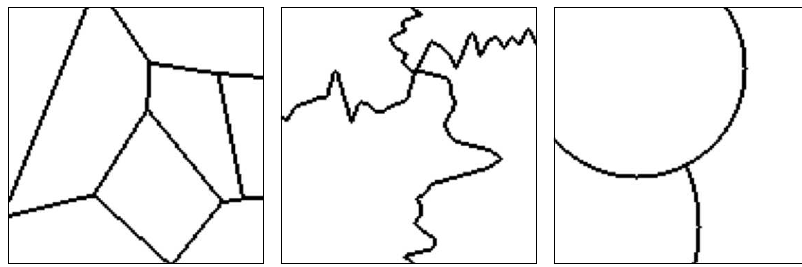
Figure 6. Example of mosaic structure and its associated borders.